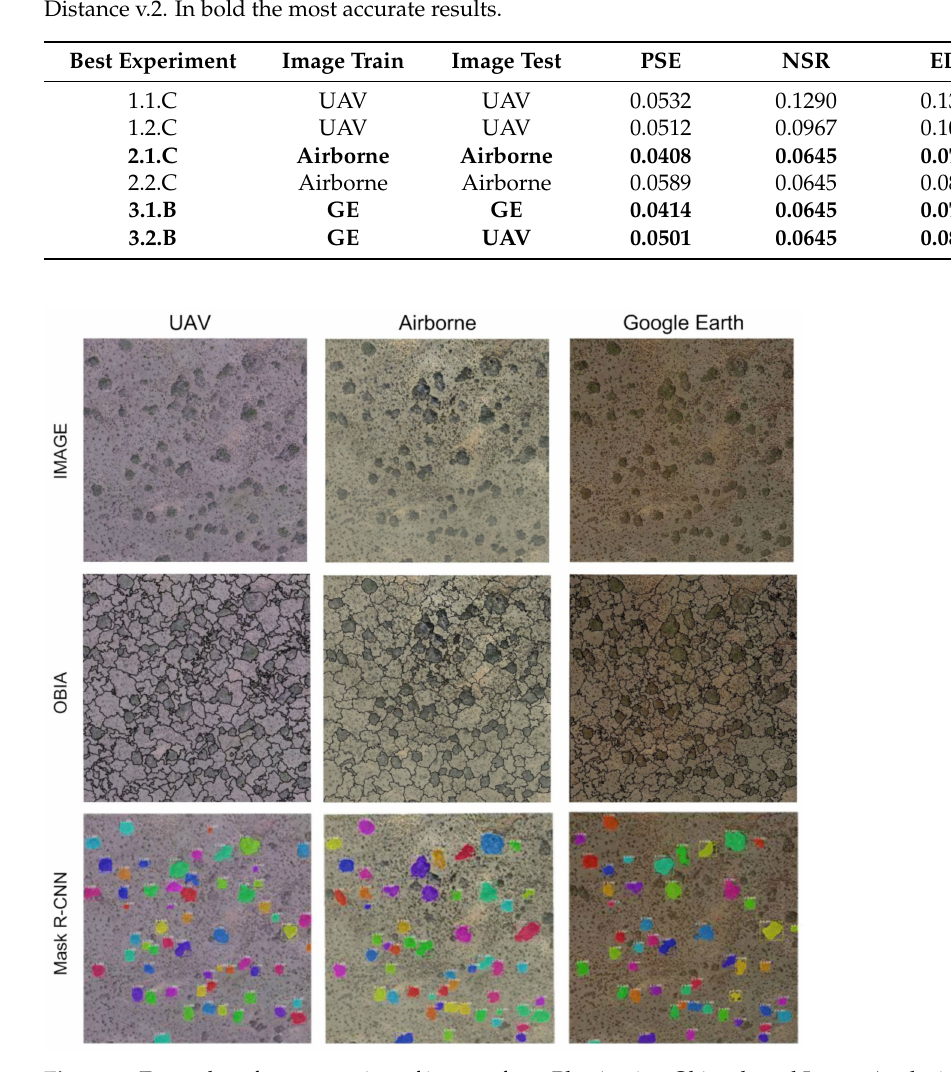
Figure 3. Examples of segmentation of images from Plot 1 using Object-based Image Analysis (OBIA; Top ) and Mask Region-based Convolutional Neural Networks (Mask R-CNN; Down ) on Google Earth, Airborne and Unmanned Aerial Vehicle (UAV) images. The different colours in the Mask R-CNN approach are to differentiate the shrubs